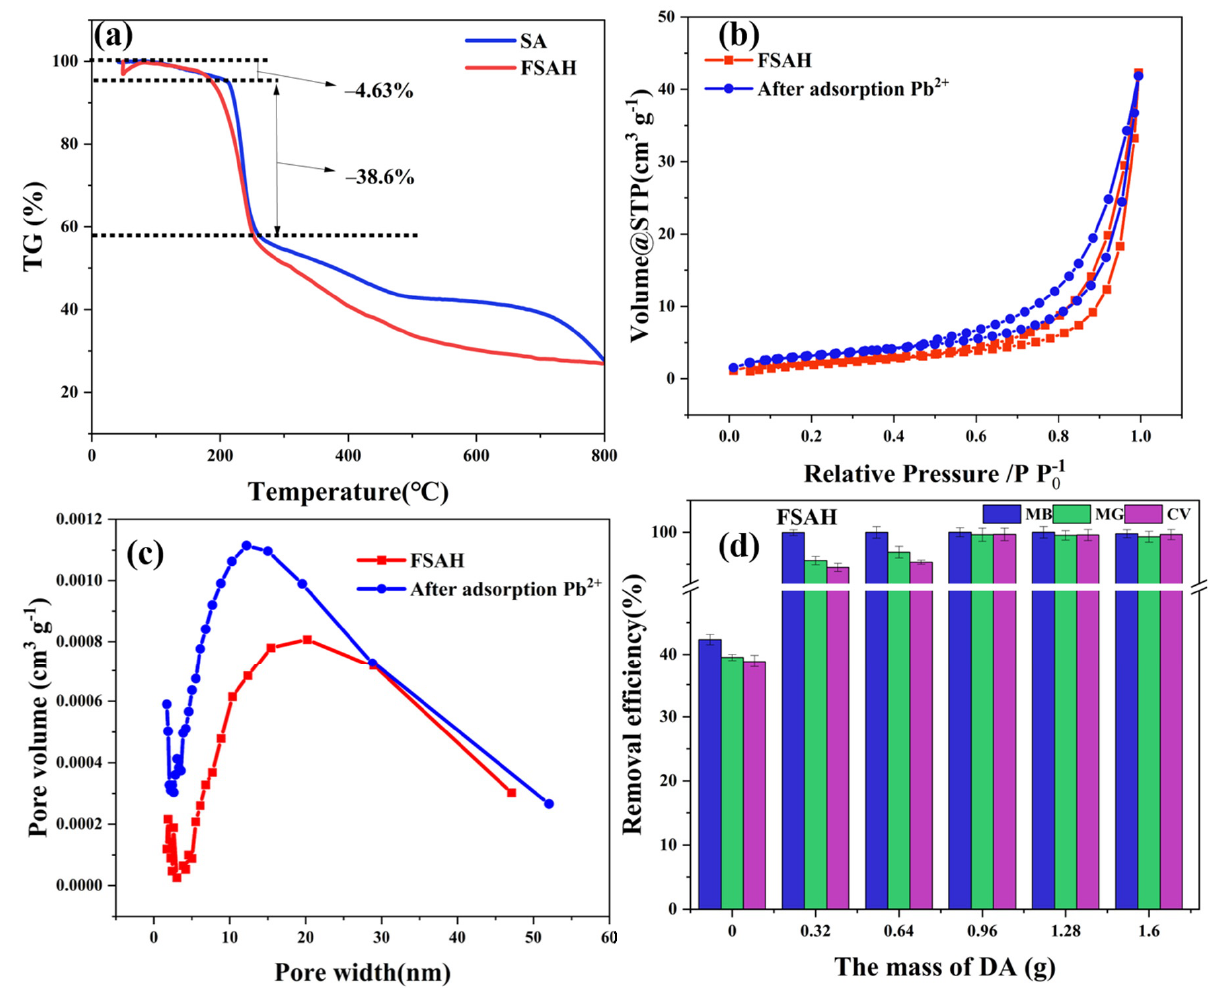
Figure 3. The TG curves of FSAH ( a ), SA BET N 2 adsorption and desorption isothermals curve for FSAH and FSAH after adsorption Pb 2+ ( b , c ), the relationship between different DA mass ratios and dye removal rates ( d ). dye removal rates ( d